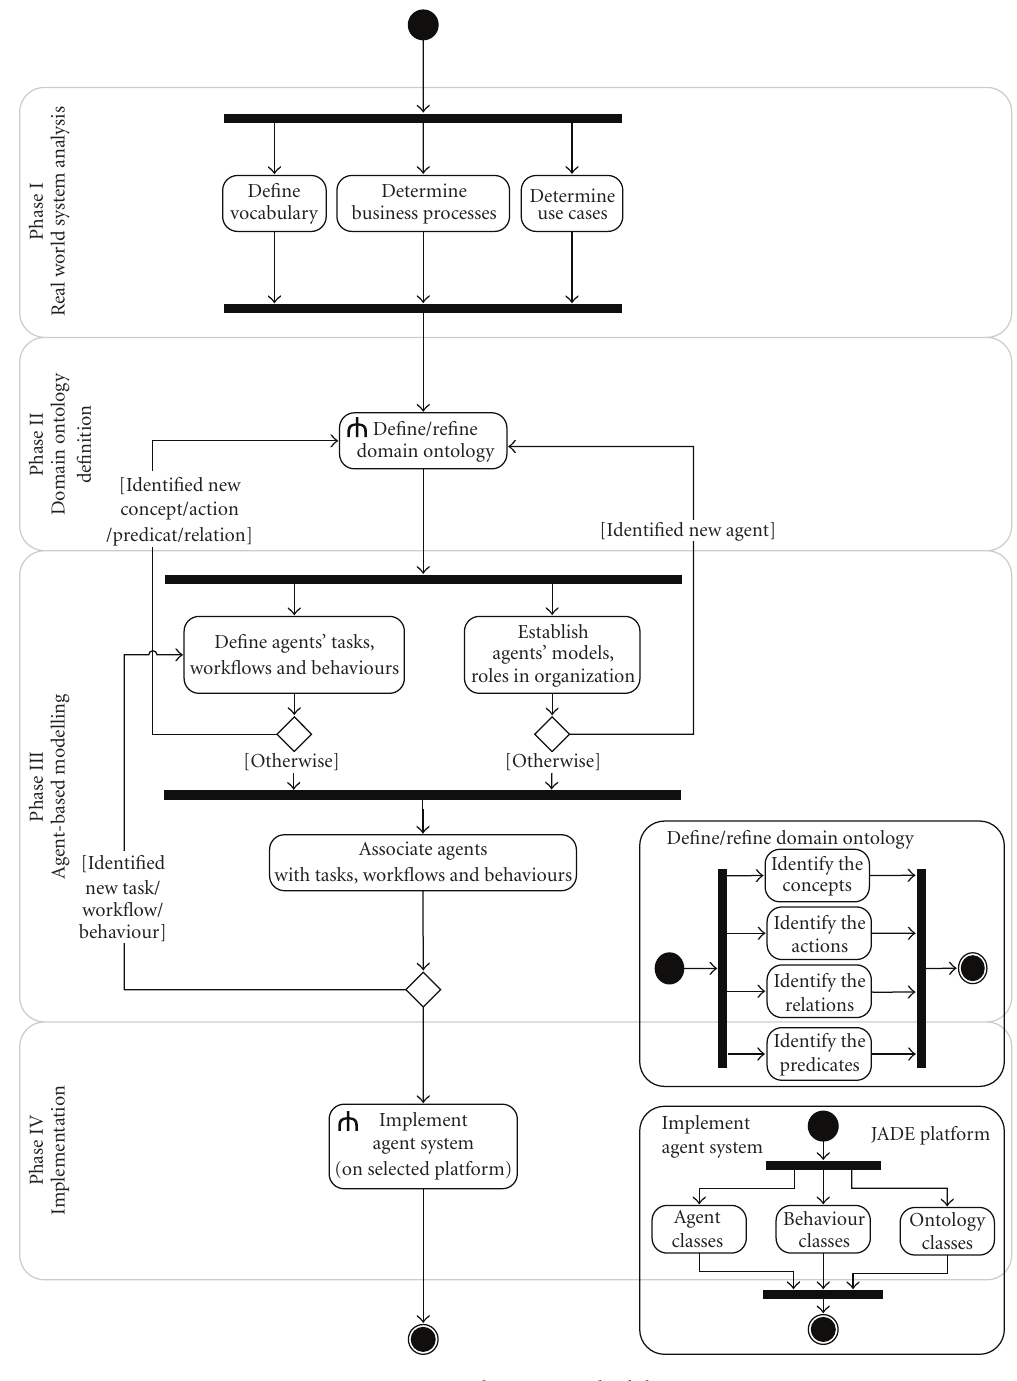
Figure 8: Development